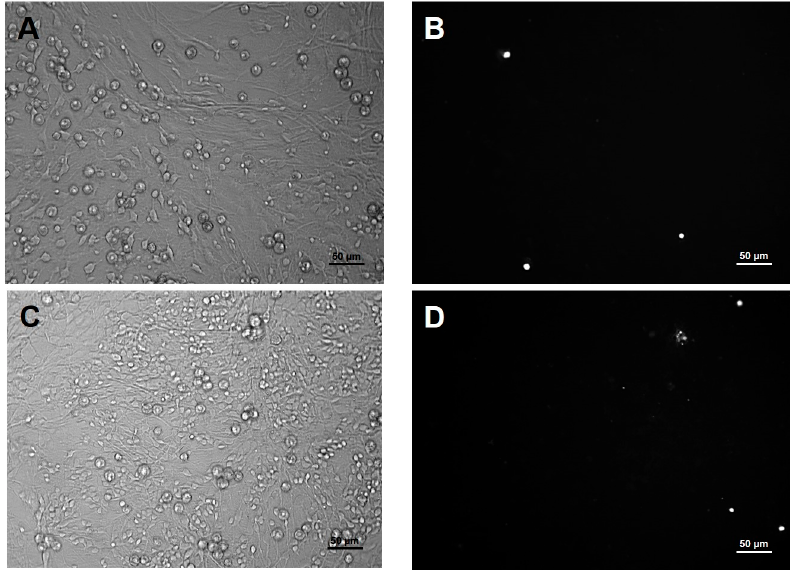
Figure 5. PI staining was used to evaluate cell viability following ZEN treatment. ( A , B ) Non-treated, Glia+ control group, ( C , D ) ZEN treated Glia+ group. PI positive cells were detected by fluorescence microscopy using a Texas red filter